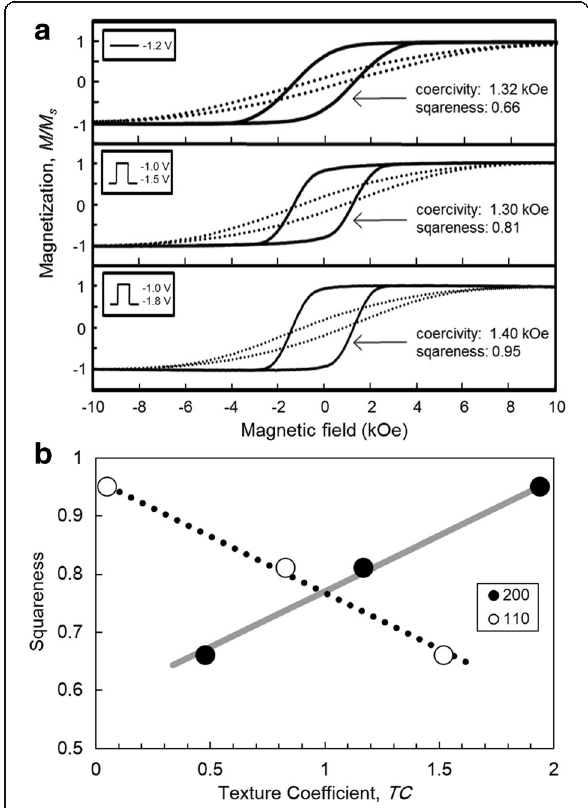
Fig. 8 Magnetic properties of Fe nanowire arrays. a Magnetic hysteresis loops with the magnetic field in perpendicular (solid line) and in-plane (dotted line) direction. b Relationship between squareness and TC 200 and TC